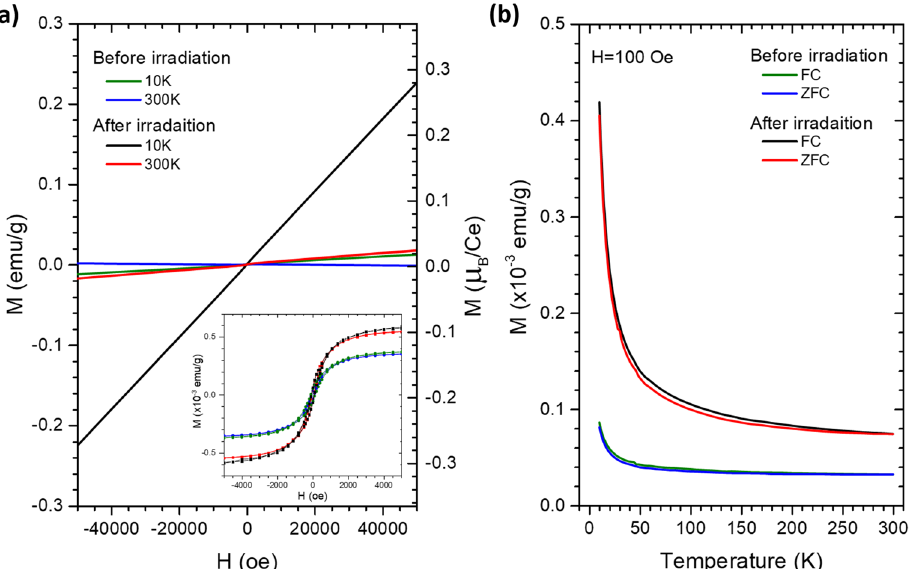
Figure 5. ( a ) M-H curves and ( b ) FC/ZFC curves of Ce-doped TiO 2 sample before and after 600 min of UV-light irradiation. The inset of ( a ) shows the ferromagnetic component of each curve obtained by subtracting the paramagnetic background from the original